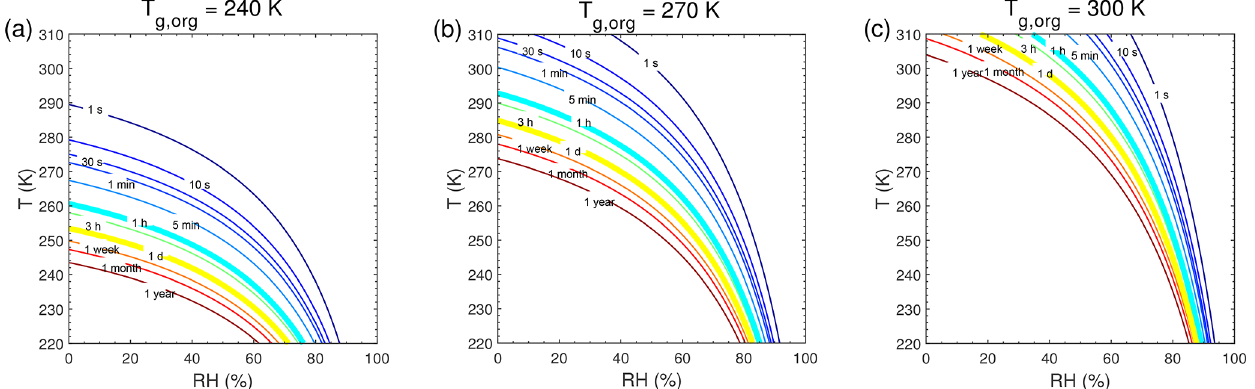
Figure A2. Characteristic timescale of bulk diffusion or mixing timescale ( τ mix ) as a function of temperature and relative humidity. The particle diameter is assumed to be 100nm with the glass transition temperatures of preexisting particles at dry conditions ( T g , org ) of (a) 240K, (b) 270K, and (c)